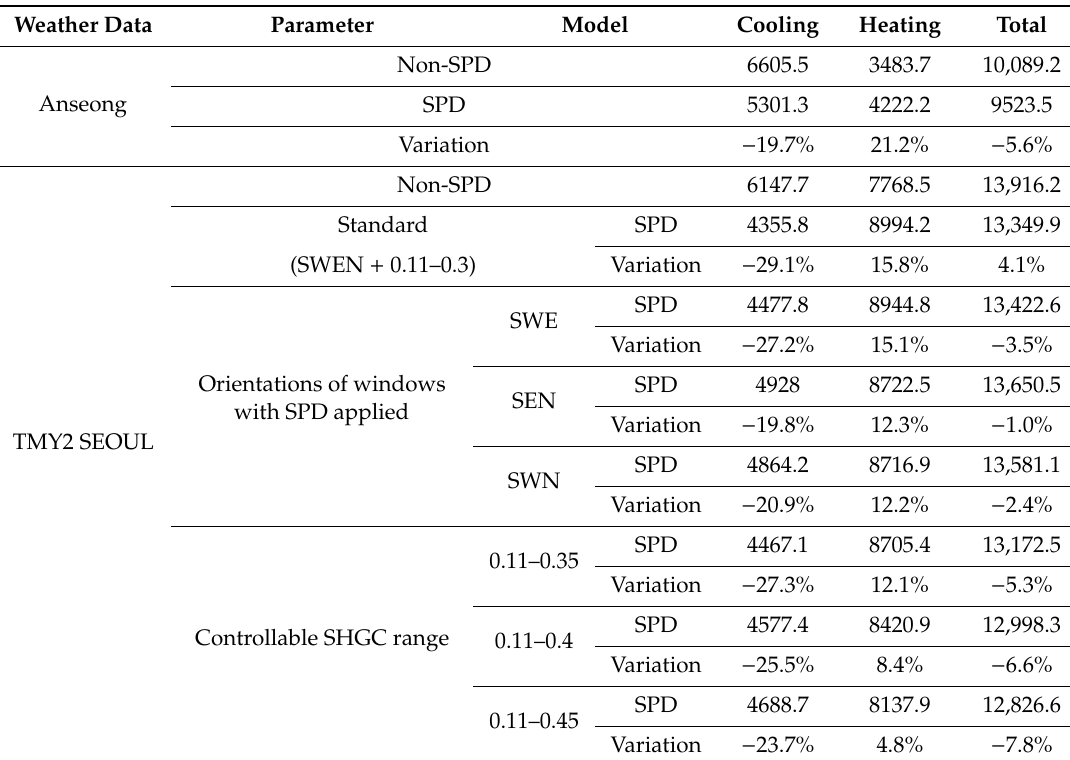
Table 11. Percent change and cooling / heating electricity consumption of SPD model compared with the non-SPD model (standard